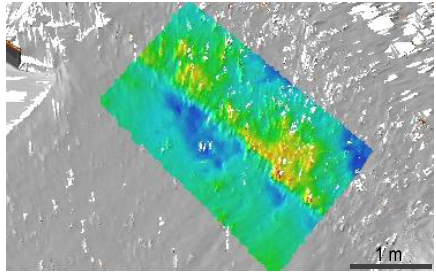
Figure 13. Detection of a terrain kink in the TLS model